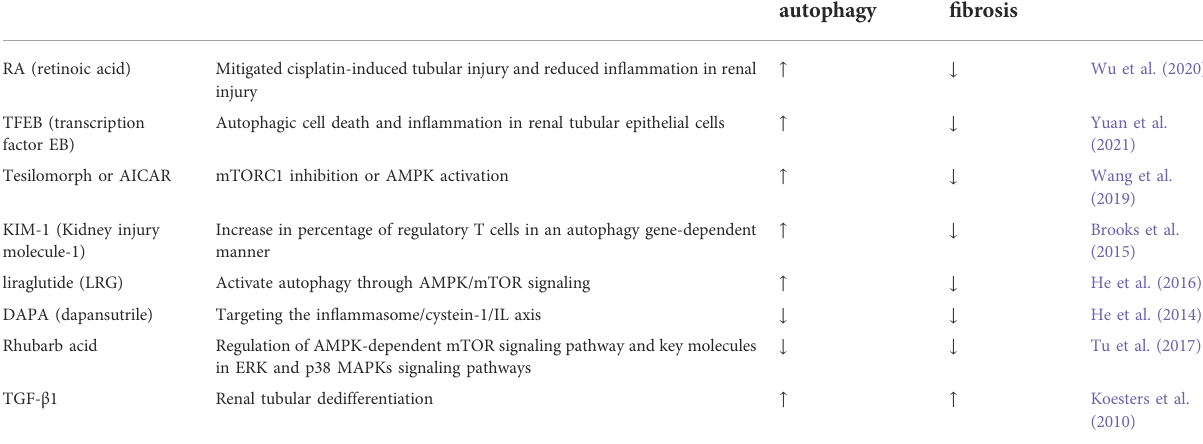
TABLE 4 Dual regulation of autophagy in other